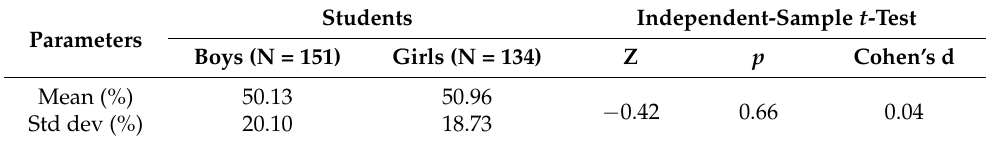
Table 7. Gender-related results of the digital test of visual communication: “produce”